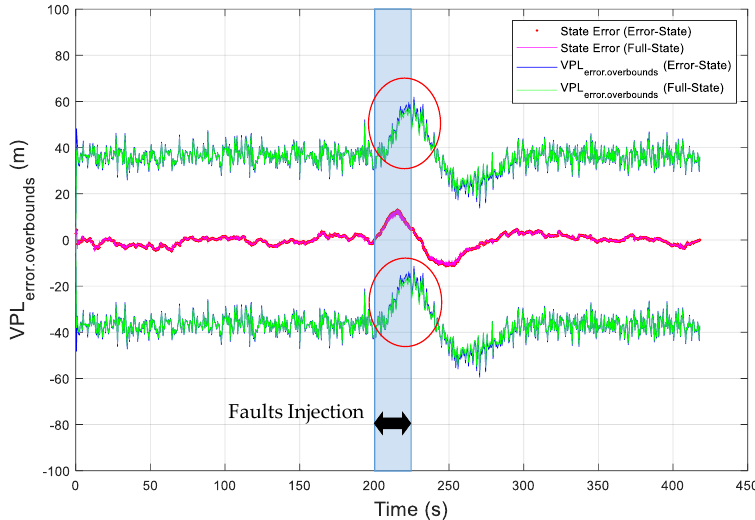
Figure 4. Simulation of the obtained error overboundings for the vertical position error.